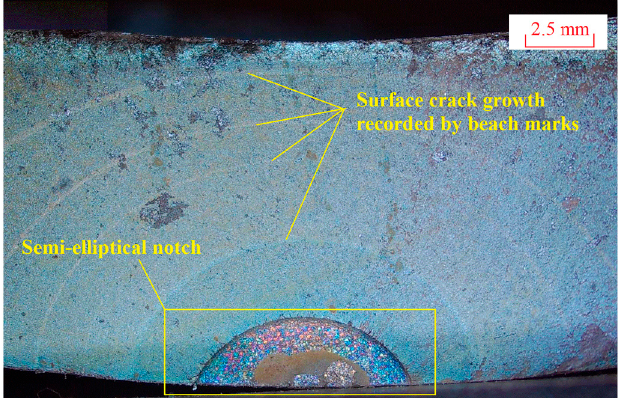
Figure 2. Circumferential semi-elliptical surface crack in metallic pipes, data from Ref. [12].